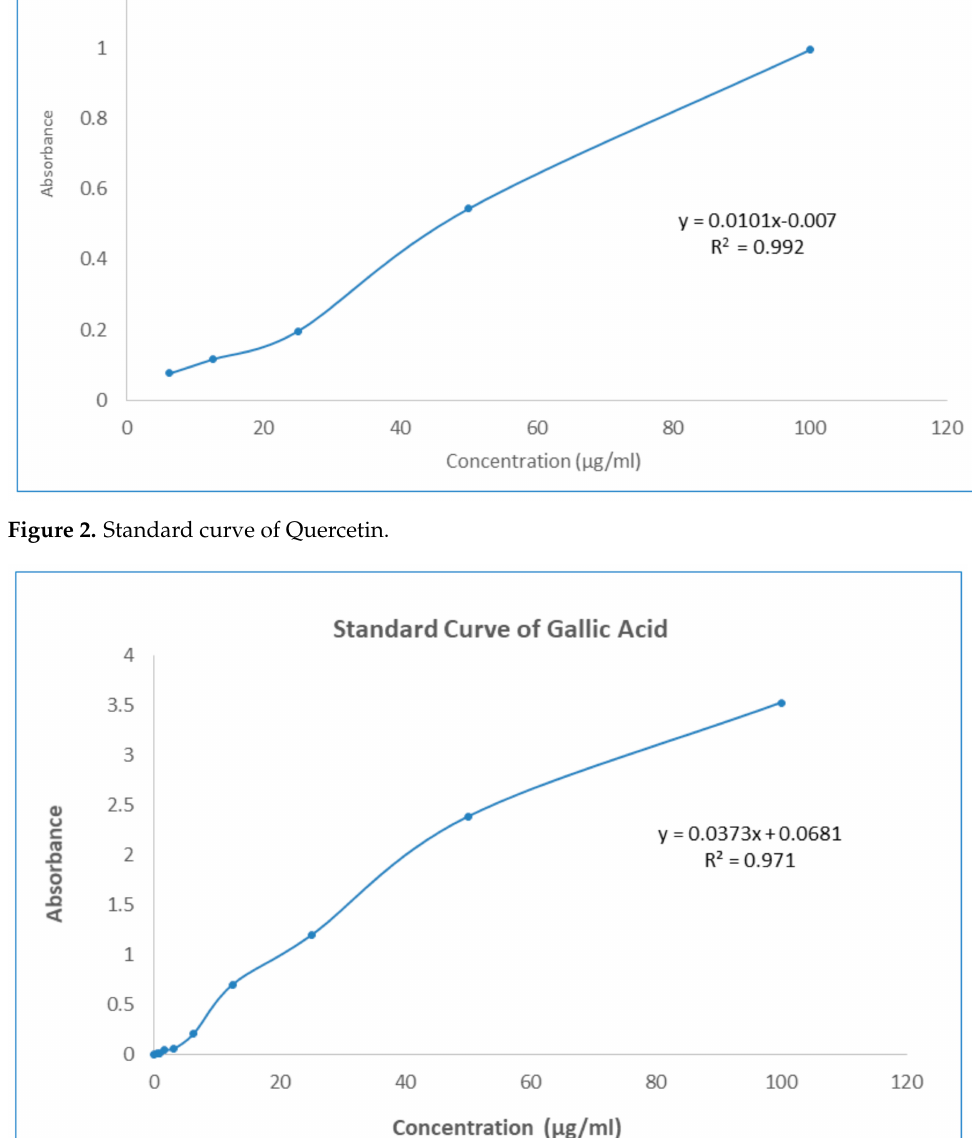
Figure 3. Standard curve of Gallic